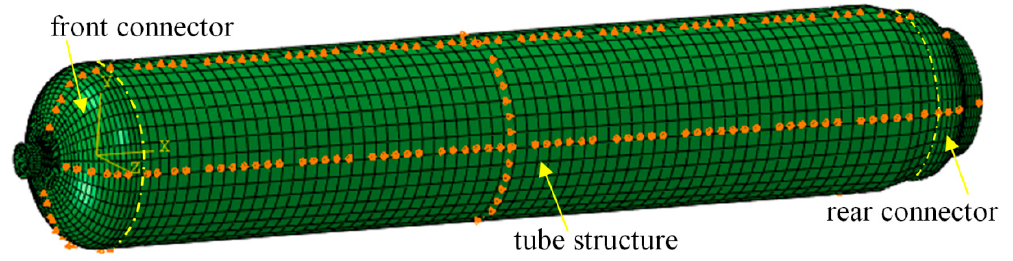
Figure 4. Schematic diagram of the RS05A motor case